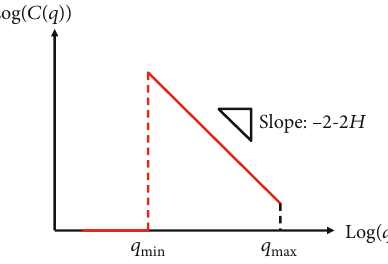
Figure 2: Schematic of the power spectrum. The horizontal axis is the frequency q ( 1/ λ ), and the vertical axis is the power C ( A 2 ). The unit for q is